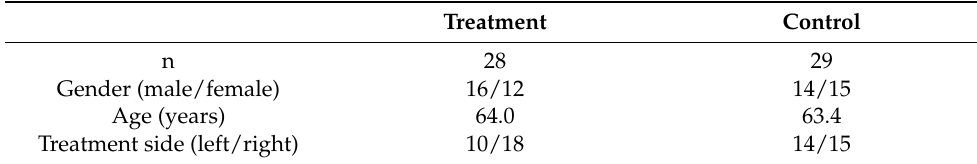
Table 1. Patient